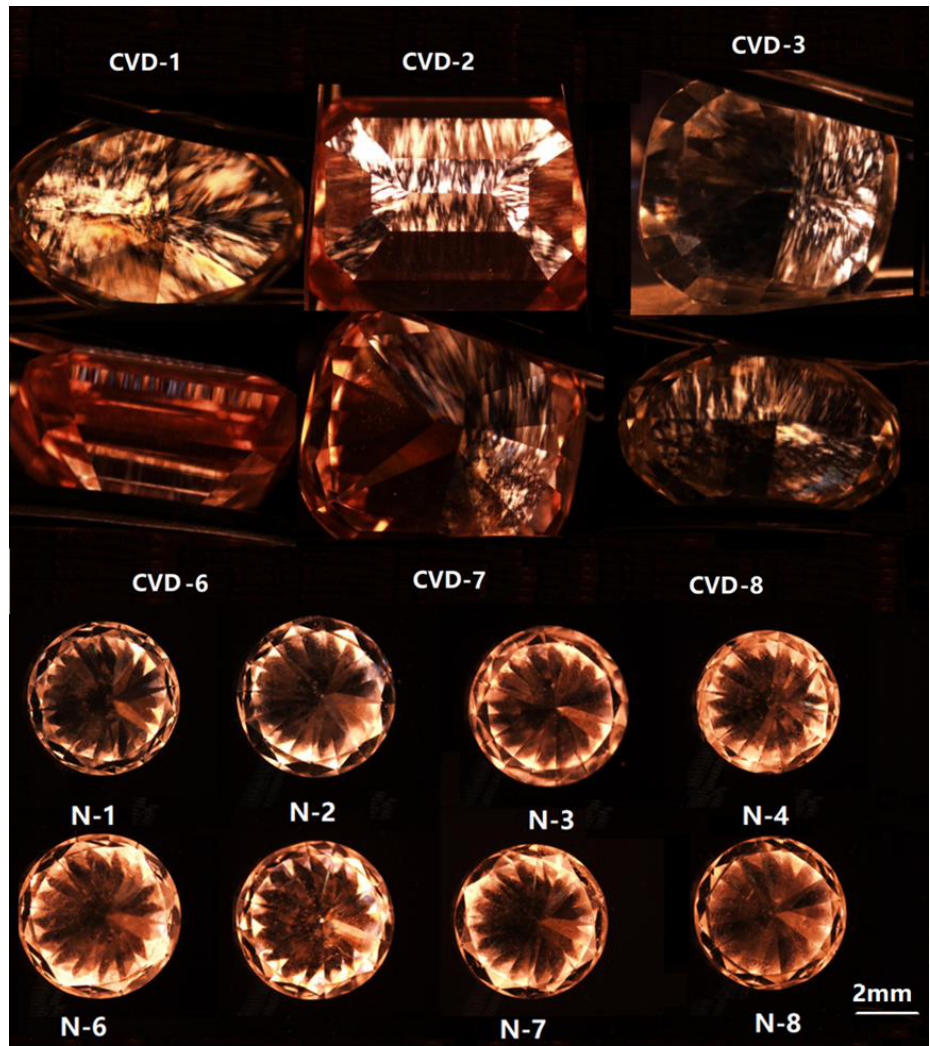
Figure 3. The interference and abnormal birefringence of samples.